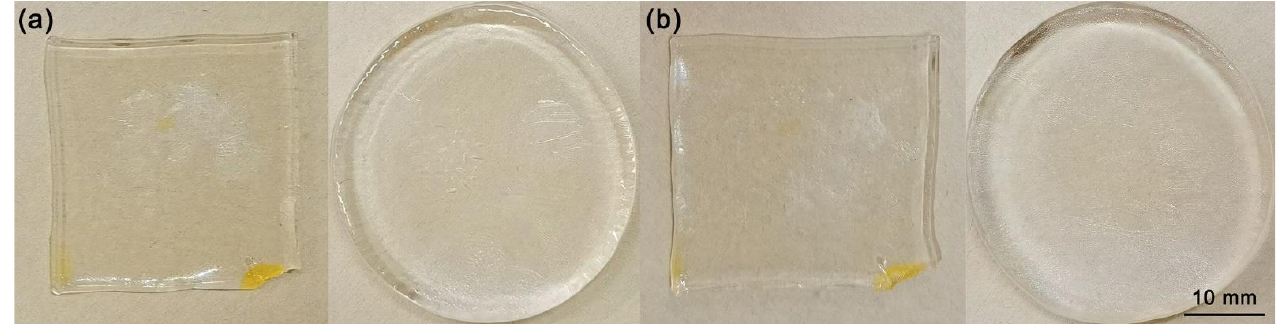
Figure 6. ( a ) Test samples in initial state; ( b ) test samples after repeated stretching 500 times.